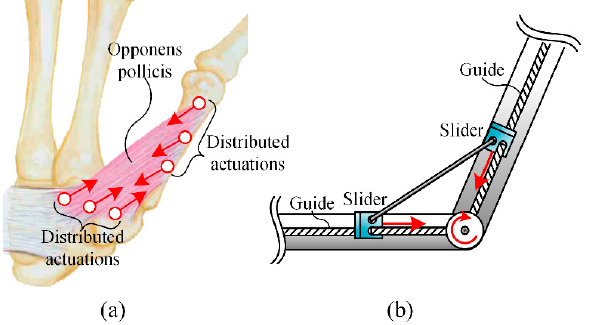
Figure 1. Actuation mechanism inspired by finger movement: ( a ) Spatially distributed actuation of a finger [24]; ( b ) A distributed actuation mechanism [22].